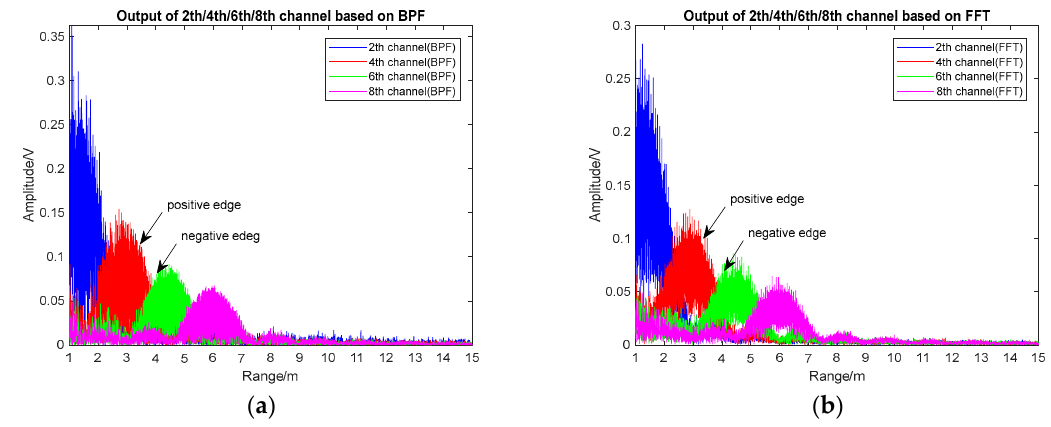
Figure 6. The outputs of the 2th/4th/6th/8th harmonic channels (SNR = − 10 dB). ( a ) The BPF-based method, and ( b ) the FFT-based method. Sensors 2017 , 17 , 2042